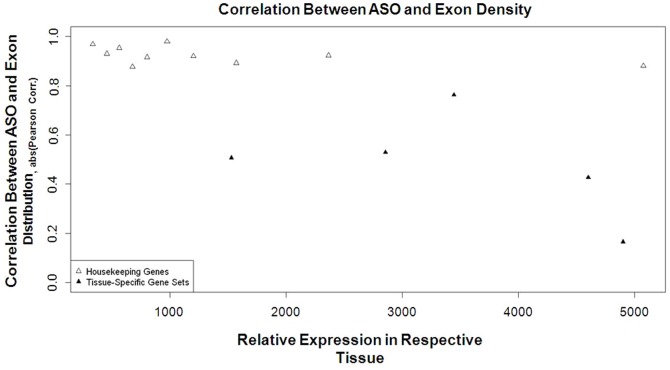
ASO bias is effected by tissue-specificity of the gene and not by relative gene expression.Genes were grouped by relative gene expression and tissue-specificity based on calculations from [57]. The Pearson's correlation coefficient was calculated between exon density and antisense retrotransposon frequency in each decile for housekeeping (empty triangle) or tissue-specific genes (filled triangle). Tissue-specific gene sets had smaller correlation coefficients than housekeeping genes and this effect was not modified by relative expression level in the respective tissue.